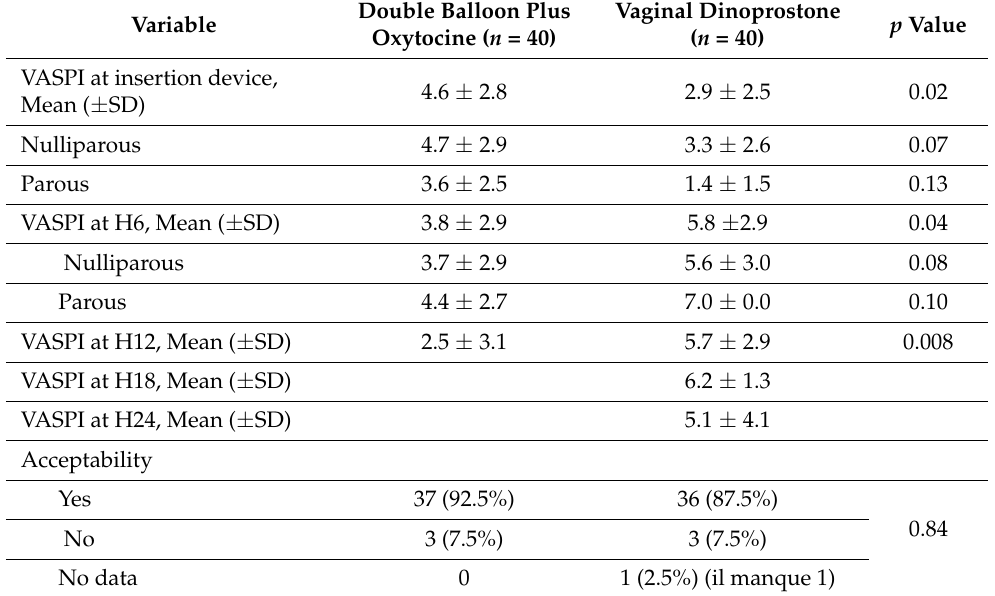
Table 6. Ripening device